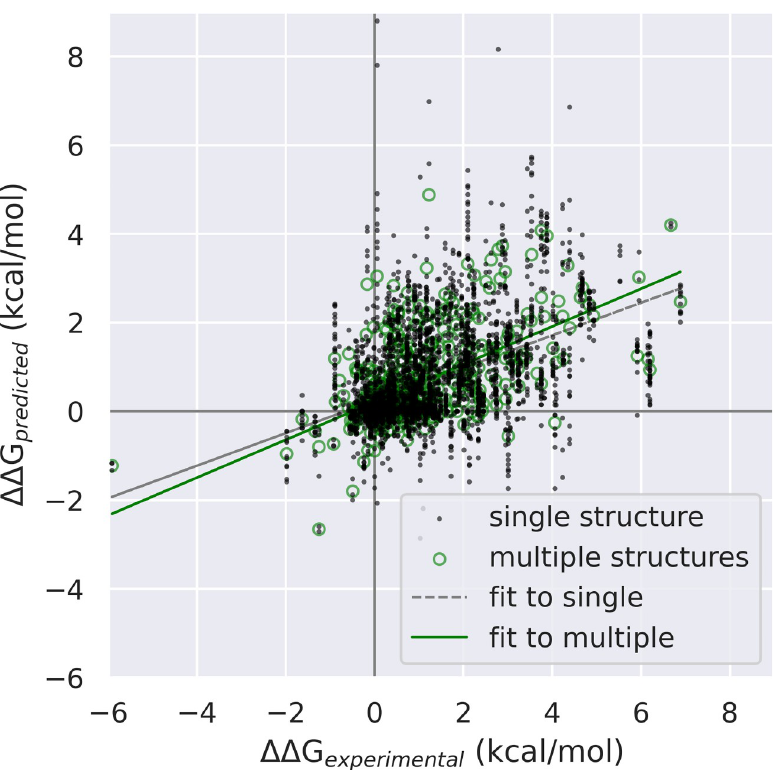
Fig 3. Scatterplot of ΔΔ G predicted vs. ΔΔ G experimental , for dataset C (single-position substitutions, where more than one structure was available). Green circles: mutants averaged over multiple structures, N = 522. Black dots: mutants computed on a single structure—as multiple structures were available for each mutant, this has a higher N = 4028. Note the clear outliers are all single-structure points. Note the third quadrant is populated with True Positives— ΔΔ G predicted and ΔΔ G experimental both negative. On the other hand, the fourth quadrant, representing False Positives, does not have any multiple-structure results below ΔΔ G predicted < -0.65 kcal/mol. The improvement in Positive Predictive Value is discussed elsewhere in this